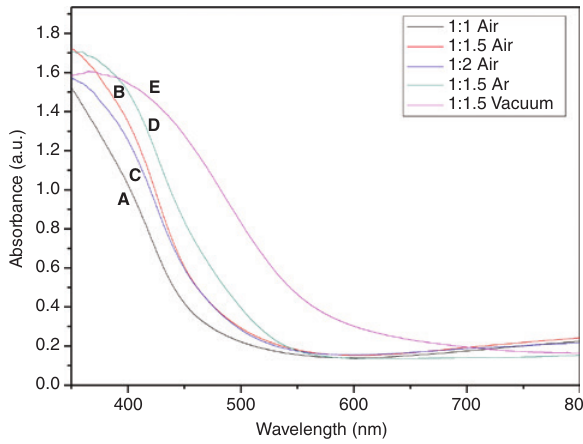
O prepared by annealing in air with 2 3